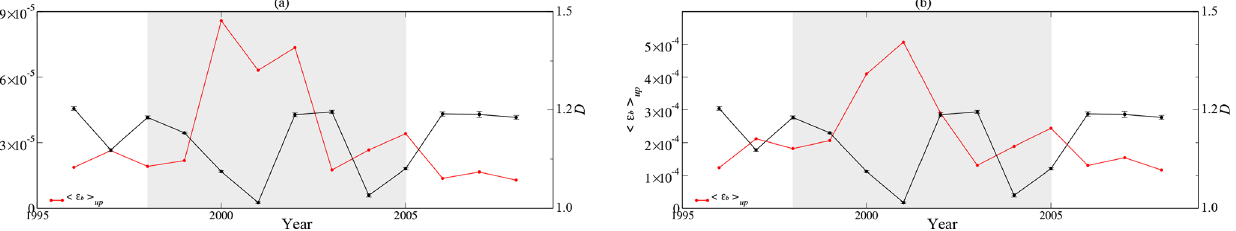
Figure 6. Same as Fig. 5, but for activity parameters (cid:104) (cid:15) b (t) (cid:105) (a) and (cid:104) (cid:15) b (cid:105) up (b) . The grey region corresponds to years of maximum solar activity, as described in the text.